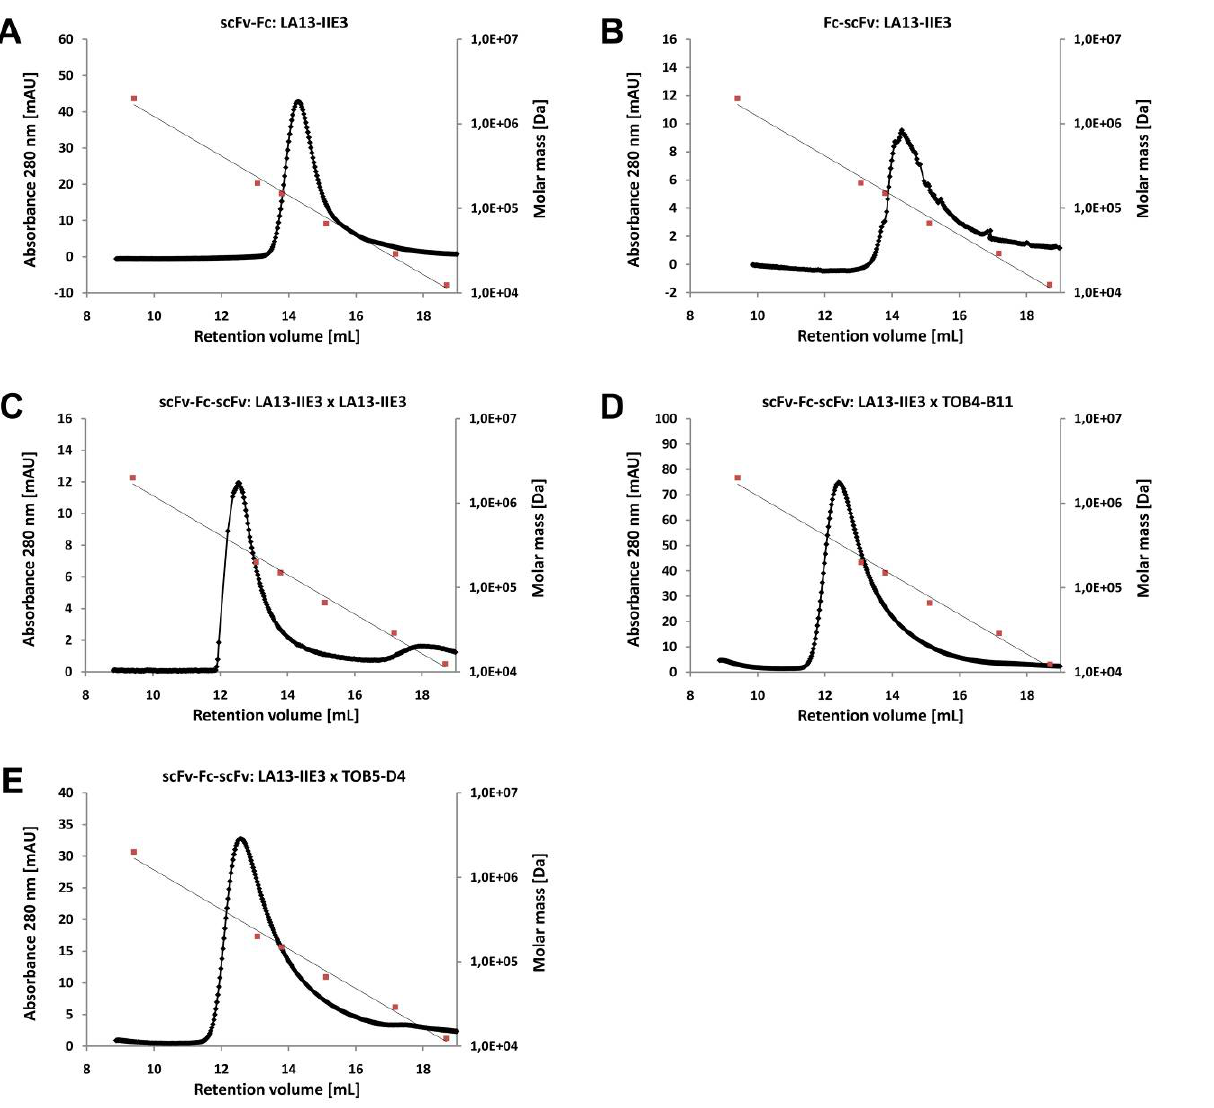
Figure 4. Homodimer formation of scFv-Fc, Fc-scFv and scFv-Fc-scFv antibodies. ( A ) ScFv-Fc LA13-IIE3, ( B ) Fc-scFv LA13-IIE3 and ( C ) scFv-Fc-scFv antibodies LA13-IIE3 × LA13-IIE3, ( D ) LA13-IIE3 × TOB4-B11, and ( E ) LA13-IIE3 × TOB5-D4 were analyzed by analytical SEC performed with a Superdex 200 20/300 GL column and Äkta purifier system using PBS as running buffer. Calibration (grey line with orange squares) was undertaken with the following molecular weight standards: blue dextran, 2,000 kDa; beta amylase, 200 kDa; alcohol dehydrogenase, 150 kDa; albumin, 66 kDa; carbonic anhydrase, 29 kDa; cytochrome C, 12.4